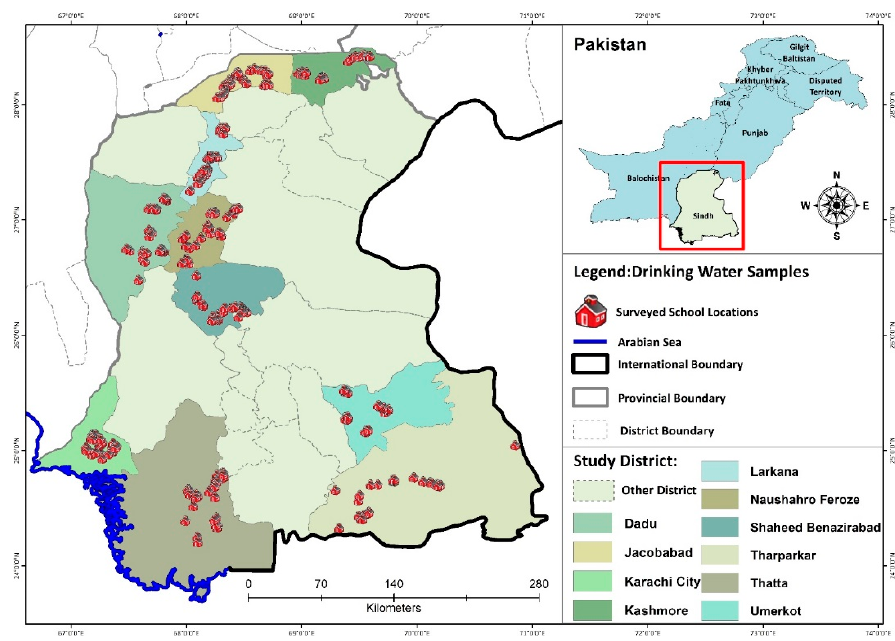
ff erent districts of